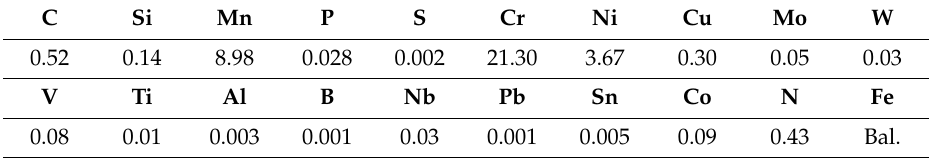
Table 2. The chemical composition of 21-4N (weight percentage, %).